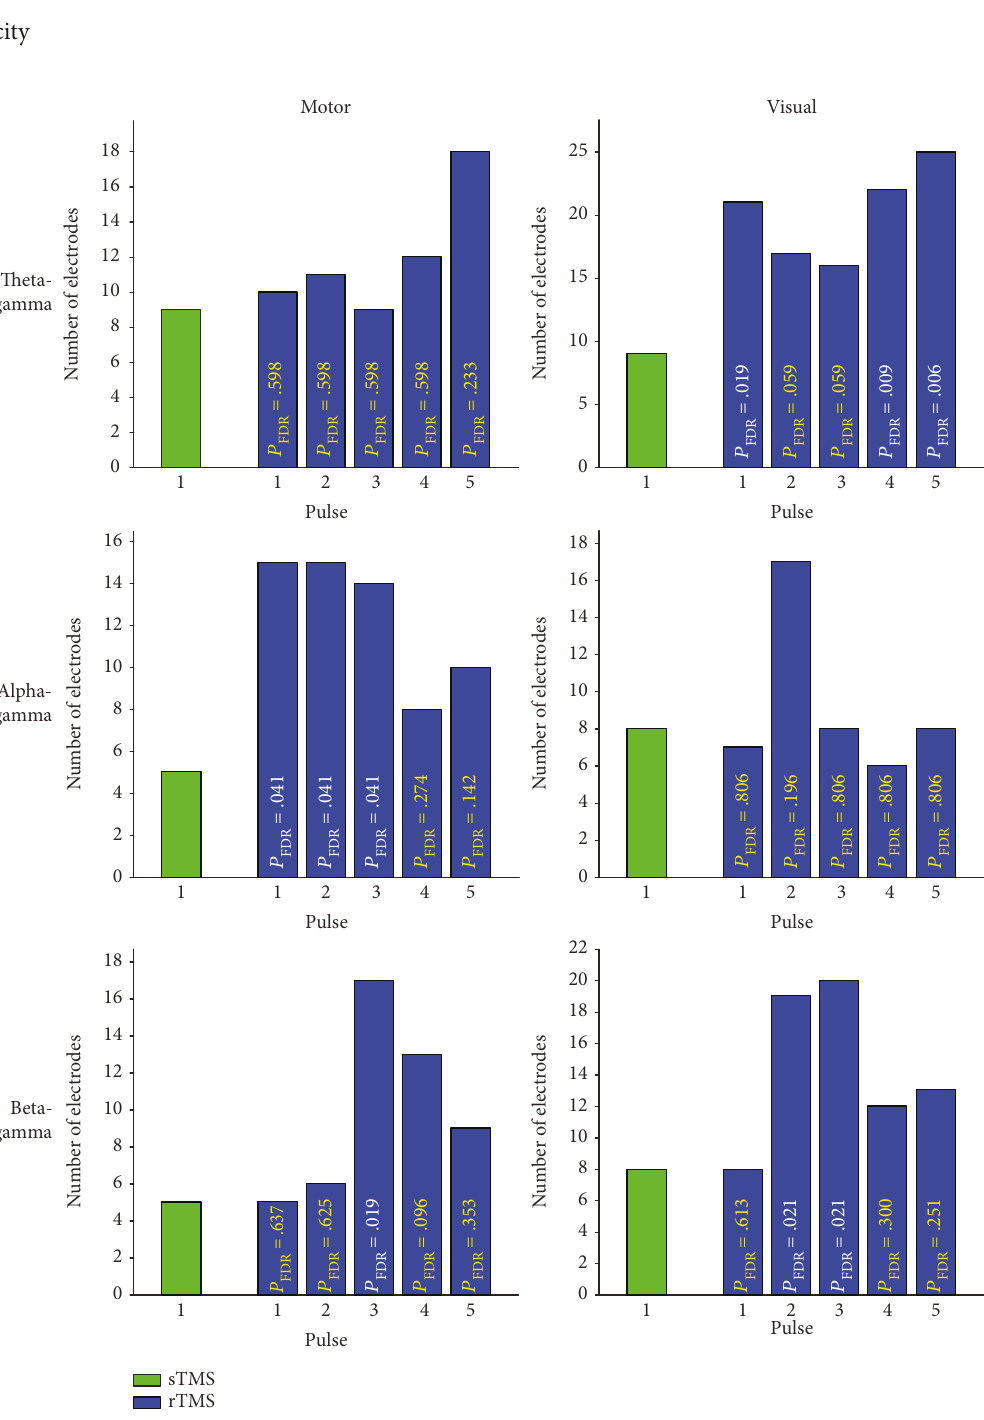
Figure 5: Global comparisons of phase-amplitude coupling between sTMS and rTMS. Plots show the spatial extent of motor-TMS-induced (left column) and visual-TMS-induced (right column) theta-gamma ( fi rst row), alpha-gamma (second row), and beta-gamma (third row) event-related phase-amplitude coupling (ERPAC) during the sTMS pulse in green and the fi ve rTMS pulses in blue, with the rTMS frequency always corresponding to the frequency of the phase series. We extracted TMS e ff ects by averaging ERPAC at all electrodes over prede fi ned time windows of interest around the respective pulses and over the sixteen amplitude frequencies, comparing the resulting values between motor or visual TMS and sham stimulation with one-tailed paired-sample Student ’ s t -tests, and counting the number of electrodes with a statistically signi fi cant di ff erence ( p ≤ 05 ; drawn on y -axis). The spatial extent of TMS e ff ects was subsequently compared between the sTMS pulse and each of the fi ve rTMS pulses with exact binomial tests. Corresponding p -values, adjusted for multiple comparisons with the false discovery rate (FDR) procedure, are superimposed onto the rTMS bars in ≤ 05 ) are displayed in white, while all other p -values are displayed in all plots; signi fi cant p -values ( p FDR